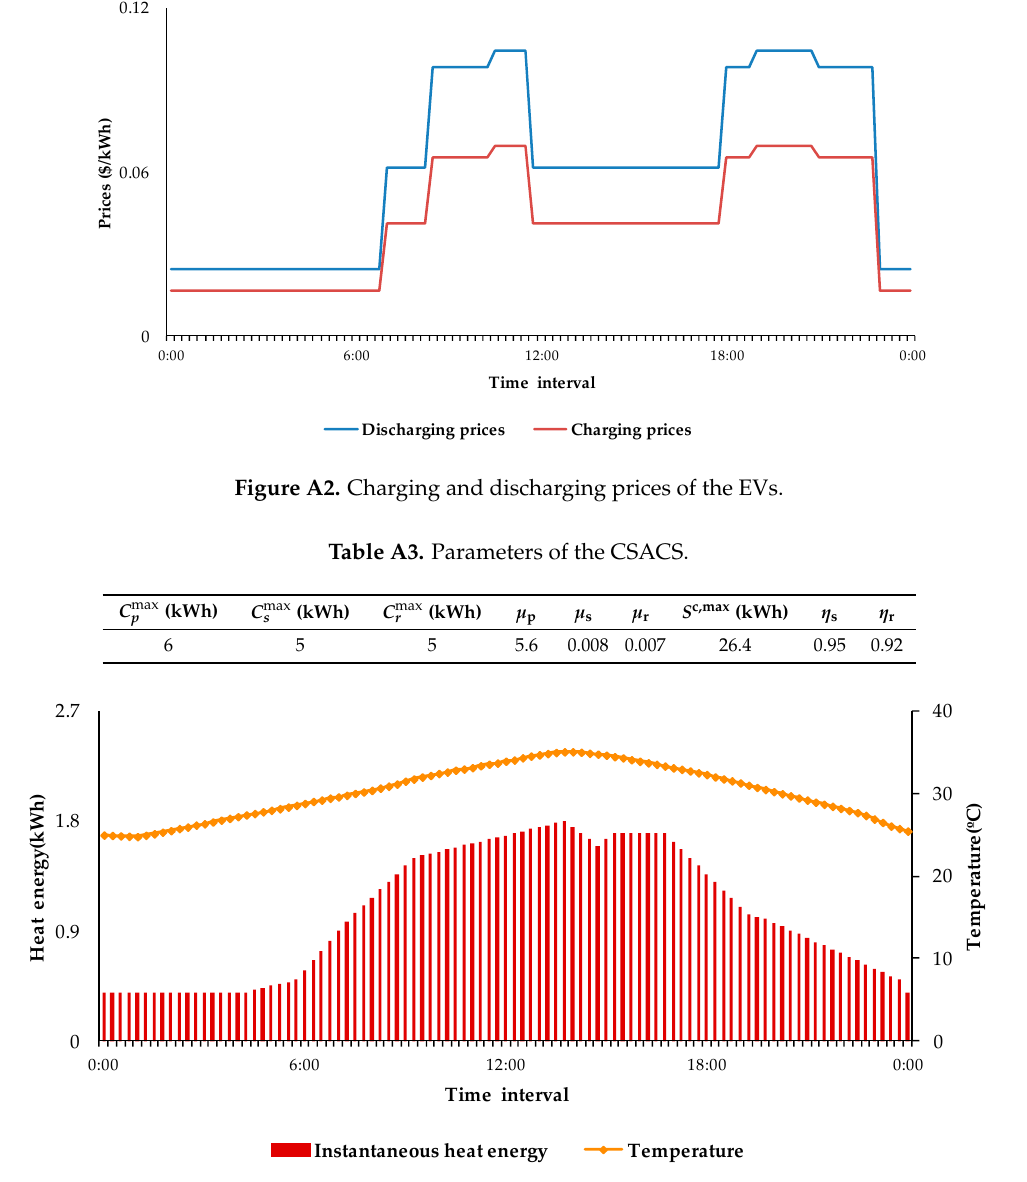
Figure A3. Instantaneous heat energy increment of each intelligent consumer and outdoor temperature.